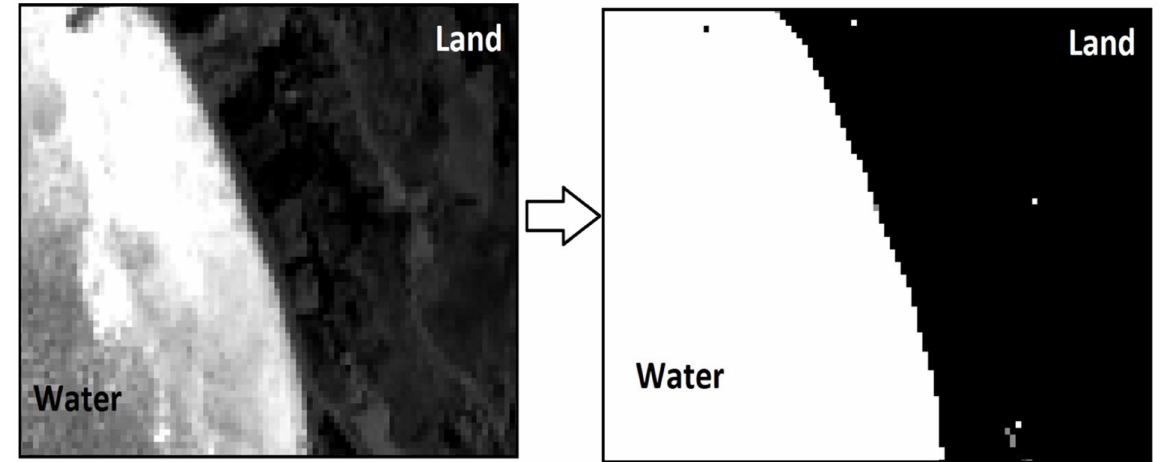
Figure 6. NDWI image of a processed multispectral satellite image of Milos Island. Water is repre- sented by the bright pixels (positive values), whereas soil or land surfaces are depicted by the dark pixels (with zero or negative